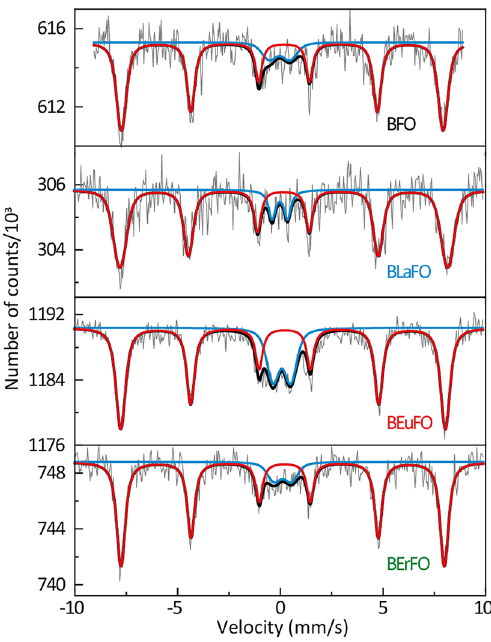
Figure 2. Room temperature 57 Fe Mössbauer spectra of BiFeO 3 and BiREFeO 3 .